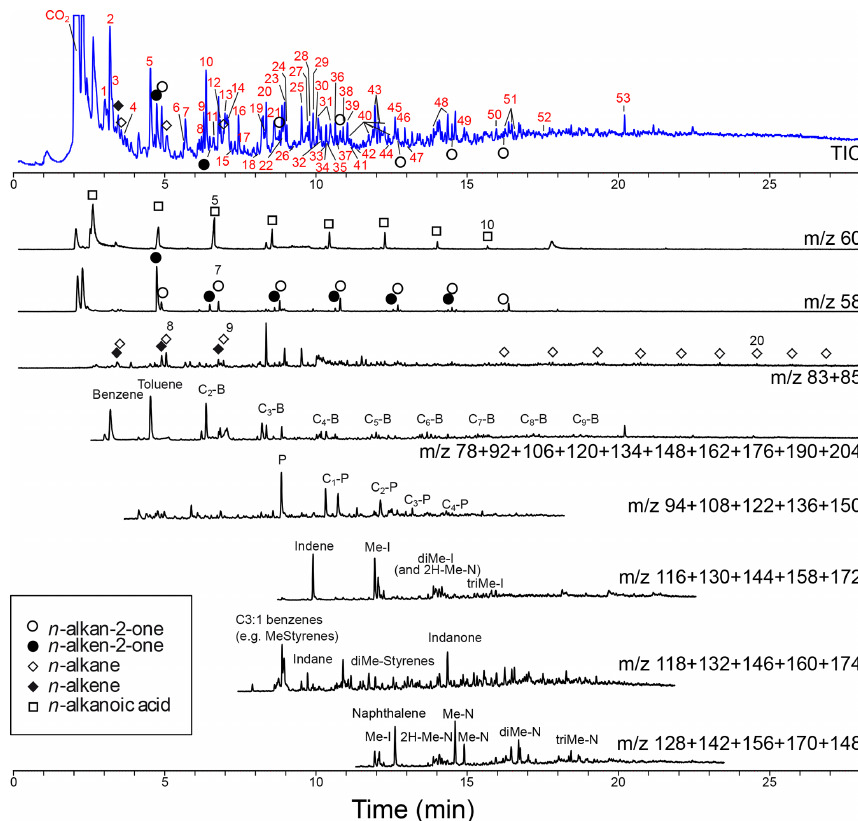
Figure 5. Chromatogram and mass chromatograms of pyrolyzed Thalassiphora pelagica cysts from the Kerguelen Plateau. For the total ion current (TIC) the compound names corresponding to numbered peaks (red numbers) are given in Table 1. For the mass chromatograms: B is benzene, P is phenol, N is naphthalene, I is indene, and “C with number” indicates the number of carbon atoms added to the basic